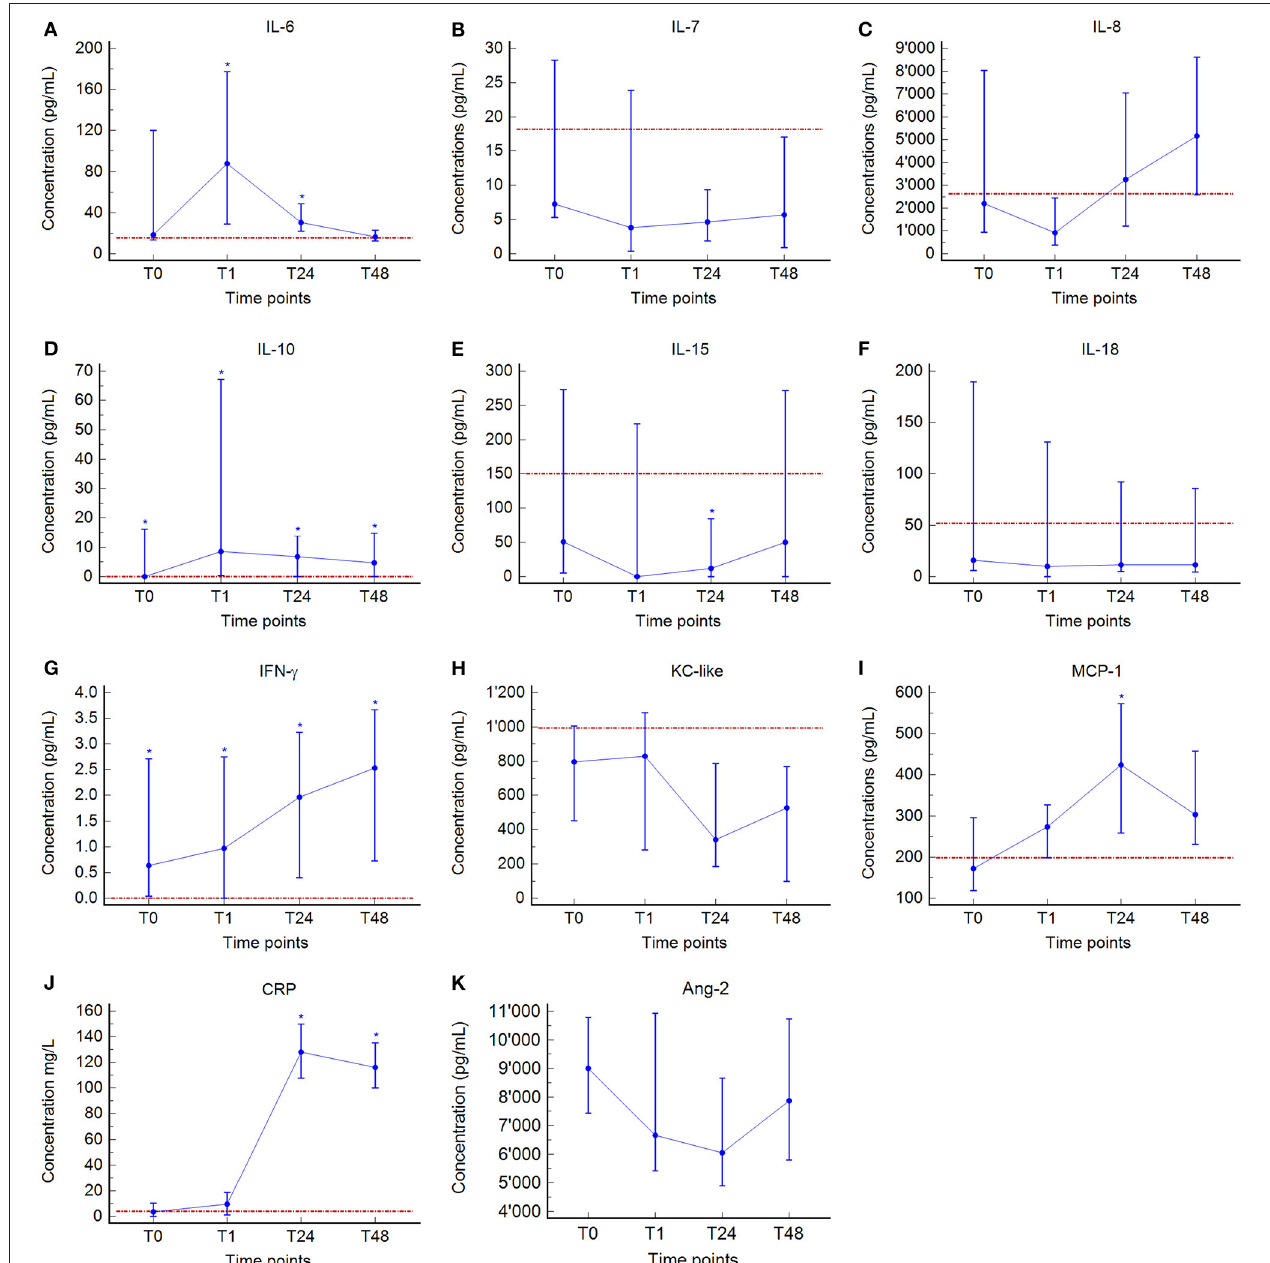
FIGURE 1 | Median (blue central value marker-dot) and interquartile range (blue error bars) of plasma concentrations of Interleukin (IL)-6 (A) , IL-7 (B) , IL-8 (C) , IL-10 (D) , IL-15 (E) , IL-18 (F) , interferon (IFN)- γ (G) , keratinocyte chemotactic-like (KC-like) (H) , monocyte chemotactic protein (MCP)-1 (I) , C-reactive protein (CRP) (J) , and angiopeietin-2 (Ang-2) (K) at admission (prior any therapeutic intervention, T0), immediately after surgery (T1), 24 h (T24), and 48 h (T48) post-surgery. Red dotted line, median of plasma concentrations of the control group. *indicates significant difference ( P < 0.05) between GDV and control dogs (Mann-Whitney test). No control group-values were available for